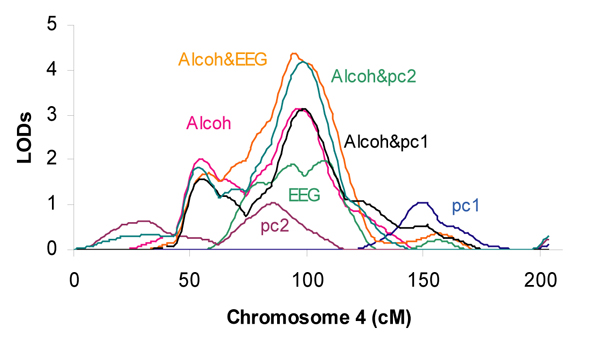
Multipoint LOD scores on chromosome 4. X-axis values are centimorgans. Y-axis values are multipoint LOD scores. Linkage analyses were conducted using multivariable residuals, adjusted for age at interview and sex.